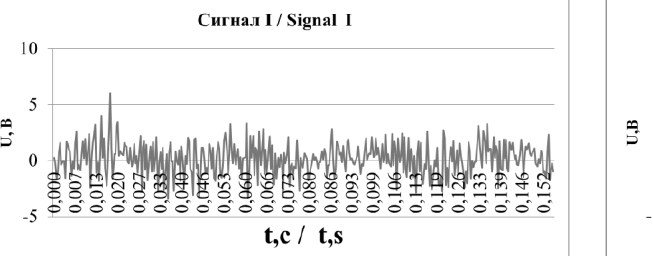
Fig. 10. The schedule of the signal II when there are no metal balls in the sensor case.